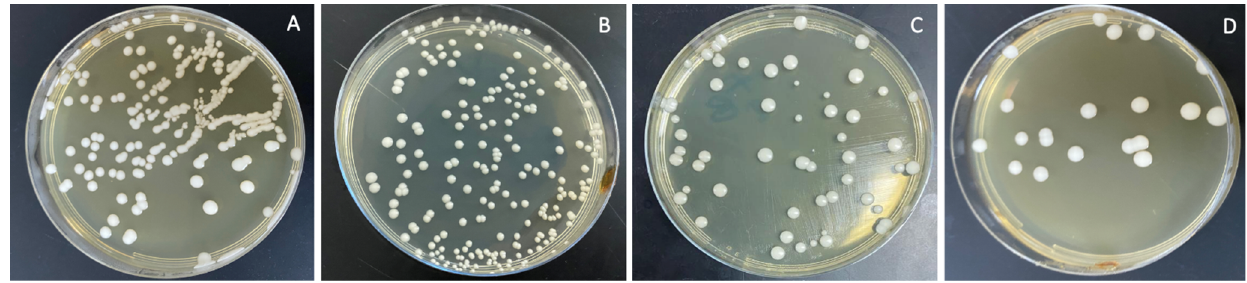
Figure 7. Cultures of Candida albicans colonies in CP/PMMA in ( A ) pure PMMA, ( B ) 0.1%, ( C ) 0.25%, and ( D ) 0.5% ND.